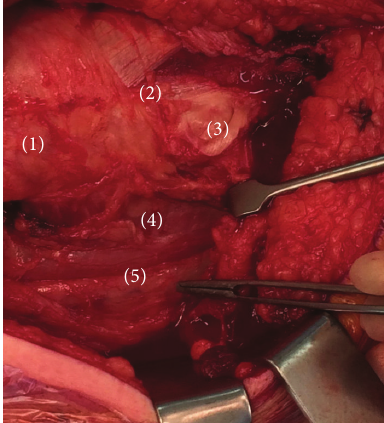
Figure4:Intraoperativeimagebeforeresectionoftheshortexternal rotators of the right hip. (1) Greater trochanter. (2) Vastus lateralis. (3) Insertion of the tendon of gluteus maximus. (4) Short external rotators of the right hip (deep to sciatic nerve). (5) Swollen sciatic nerve.